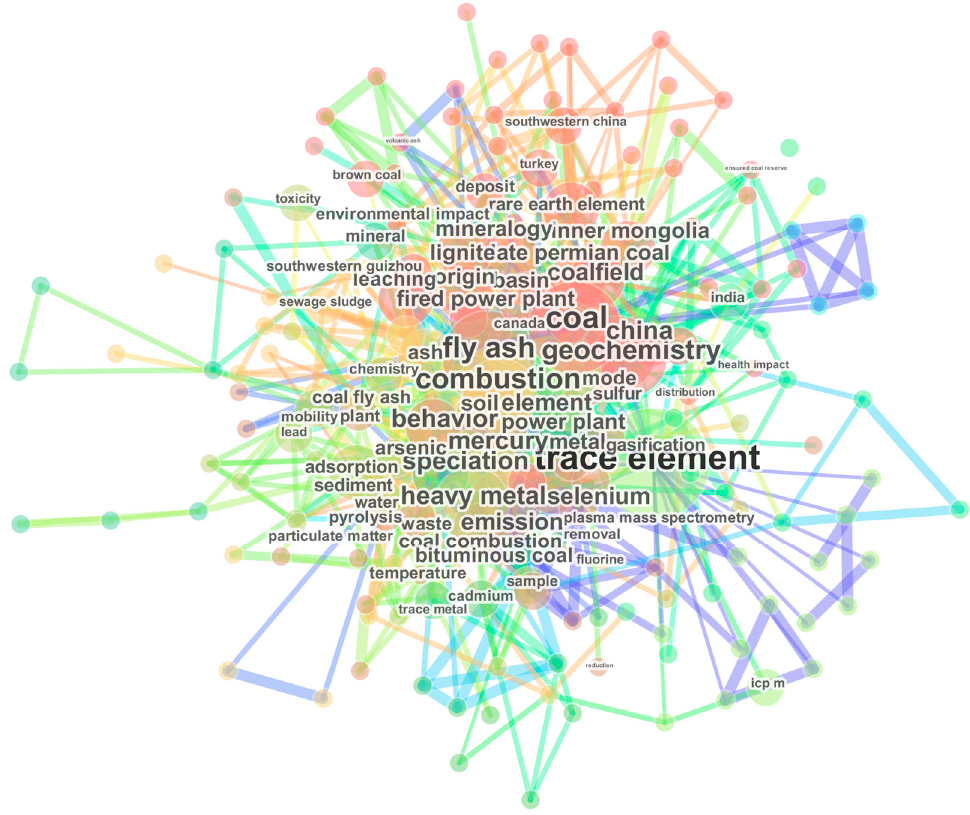
Figure 8. The co-occurrence of keywords of trace elements in coal and ash.